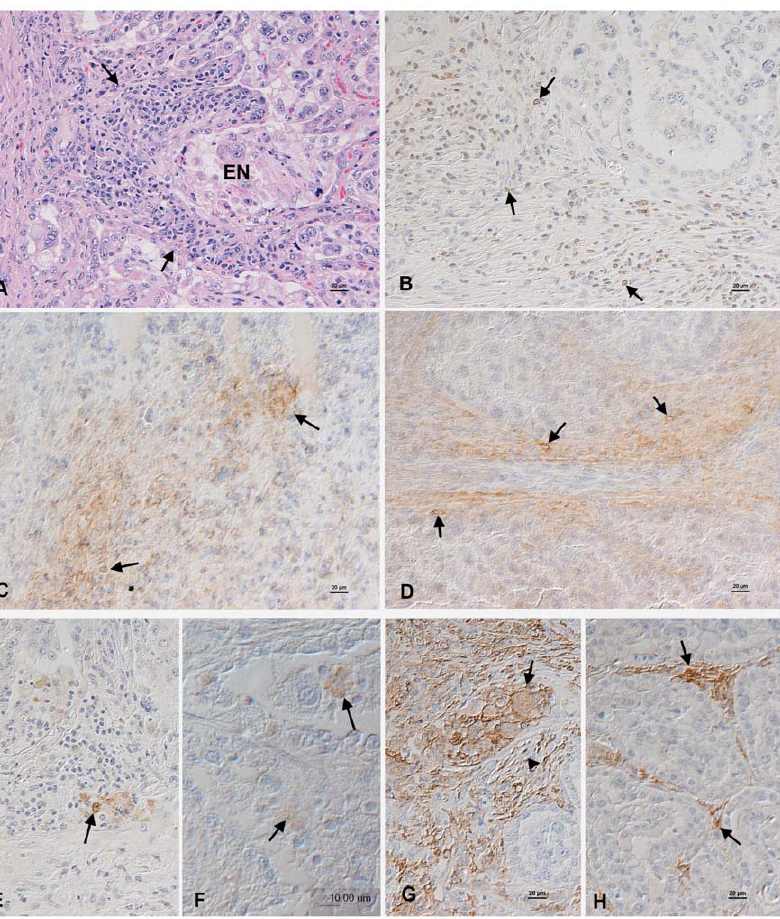
Figure 2. Histology and immunohistology in the placenta after parasite recrudescence. Placenta after parasite recrudescence. A. Animal no. 5, 32 weeks of gestation. There is a focal area of epithelial cell necrosis (EN) and a focal lymphocyte-dominated mononuclear interstitial inflammatory infiltrate (arrows). Haematoxylin-eosin stain. B–D. Animal no. 2, 25 weeks of gestation. The inflammatory infiltrate is dominated by CD3- positive T cells (B, arrows) which are comprised of CD4 + (C) and CD8 + (D) T cells (arrows). E. Animal no. 7, 35 weeks of gestation. Macrophages, as highlighted by their expression of myeloid/histiocyte antigen (arrow) are very rare in the inflammatory infiltrates. F. Animal no. 2, 25 weeks of gestation. Neospora antigen is observed within foetal chorionic epithelial cells (top arrow) and in cell free tachyzoites (bottom arrow) in areas of epithelial cell necrosis. G. Animal no. 2, 25 weeks of gestation. MHC Class II antigen expression is seen in foetal and maternal epithelial cells (arrow) and in stromal fibroblastoid cells (arrowhead). H. Control animal, 30 weeks of gestation. There is patchy MHC Class II antigen expression by stromal fibroblastoid cells (arrows). B–H. Peroxidase anti-peroxidase method, Papanicolaou’s haematoxylin counterstain.